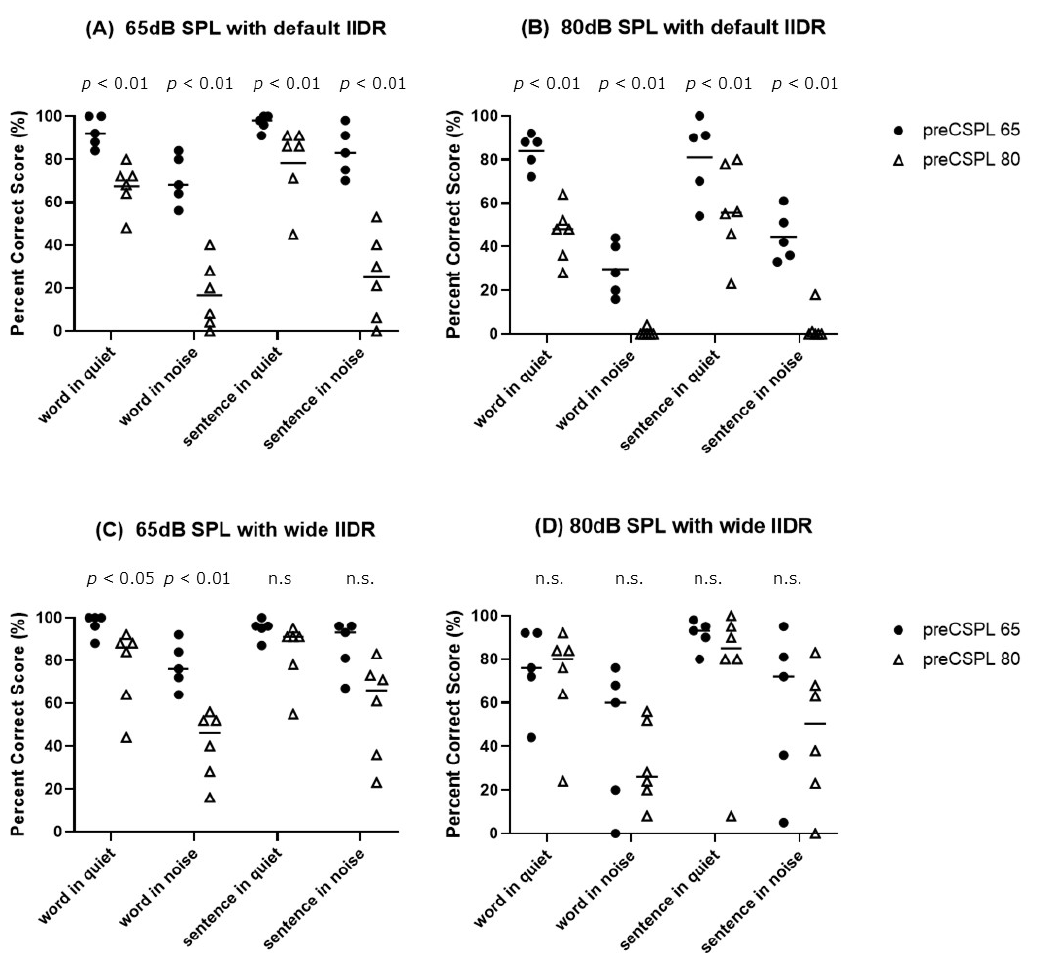
Figure 4. CI2004 word and sentence test results with default IIDR/wide IIDR compared between the preCSPL65 and preCSPL80 groups at ( A , C ) normal and ( B , D ) loud conversation levels. Mean words in quiet, words in noise, sentences in quiet, and sentences in noise scores were ( A ) 92.8%, 70.4%, 97.0%, 83.4%, ( B ) 84.0%, 29.6%, 81.0%, 44.6%, ( C ) 96.8%, 77.6%, 94.8%, 86.6%, and ( D ) 75.2%, 44.8%, 91.2%, 57.8%, respectively, in preCSPL65 and ( A ) 67.3%, 16.6%, 78.3%, 25.0%, ( B ) 46.0%, 0.67%, 56.3%, 3.2%, ( C ) 76.7%, 40.7%, 83.5%, 57.8%, and ( D ) 70.7%, 31.3%, 75.5%, 45.8%, respectively, in preCSPL80. ( A , B ) Significant differences were seen in all tests ( p < 0.01), and there was a clear separation between words in noise and sentences in noise. ( C ) Significant differences were seen in quiet ( p < 0.05) and in noise ( p < 0.01) conditions. ( D ) There was no significant difference in all